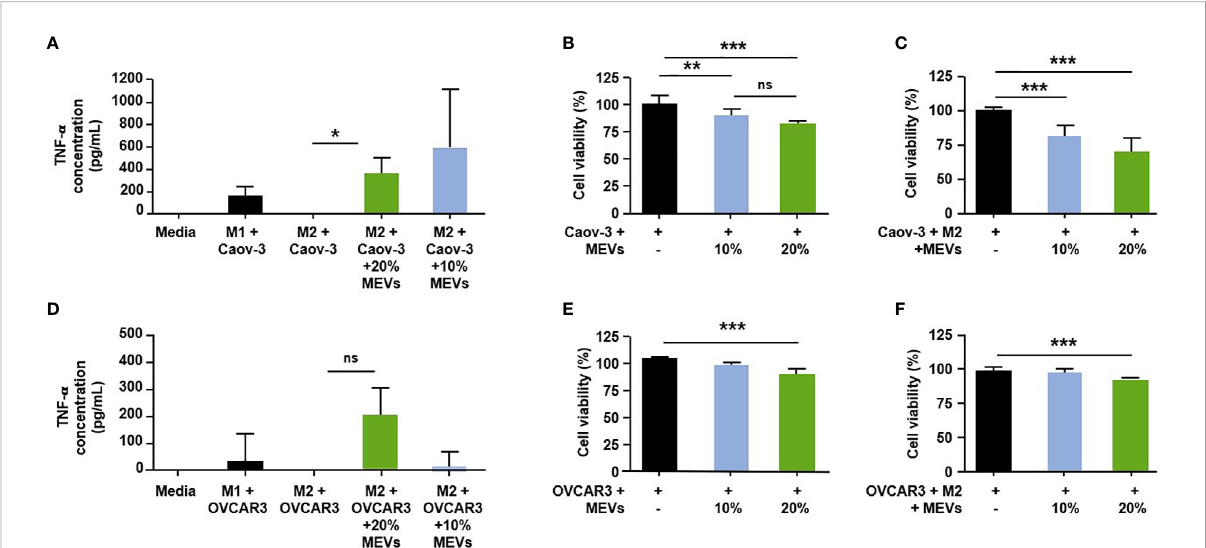
FIGURE 5 Human M1 MEVs shift co-cultured M2 macrophages to M1 phenotype. (A, D) . Supernatants were collected 24 hours after the addition of M1 MEVs (48 hours after macrophage plating). Supernatants were assayed in duplicate using a human TNF- a Quantikine ELISA kit (R&D Systems, Inc.). Signi fi cance was assessed with a two-tailed paired t-test (A, D) ; p = 0.0259 & p=0.18, respectively). Human M1 MEVs show dose-dependent inhibition of cell viability in co-cultured cells. Graphs indicate the percent cell viability of the (B) Caov-3 cancer cells alone and (E) OVCAR3 cancer cells alone treated with M1 MEVs or (C) Caov-3 and (F) OVCAR3 co-cultured cancer cells plus M2 macrophages treated with M1 MEVs. Cell viability was measured at 96 hours (CellTiter-Glo 2.0). % of MEVs refers to the relative percentage of supernatant with MEVs added. The percent cell viability was calculated by comparing cells treated with M1 MEVs to the respective untreated control. Statistical analyses were performed using Kruskal- Wallis with Dunn ’ s Multiple Comparison posthoc test (*p < 0.05; **p < 0.01; ***p < 0.001). Experiments were performed in triplicate. Bars correspond to SEM. * indicates a p<0.05.